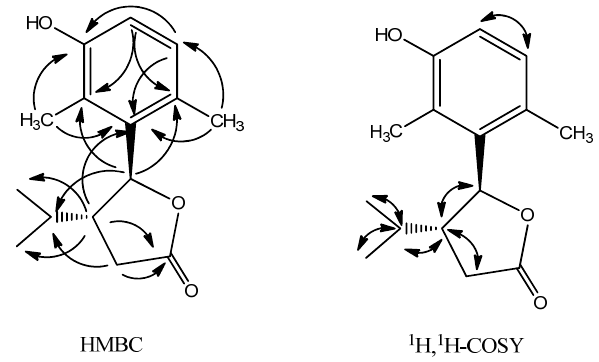
Figure 3. Key HMBC and 1 H, 1 H-COSY correlations of compound 2